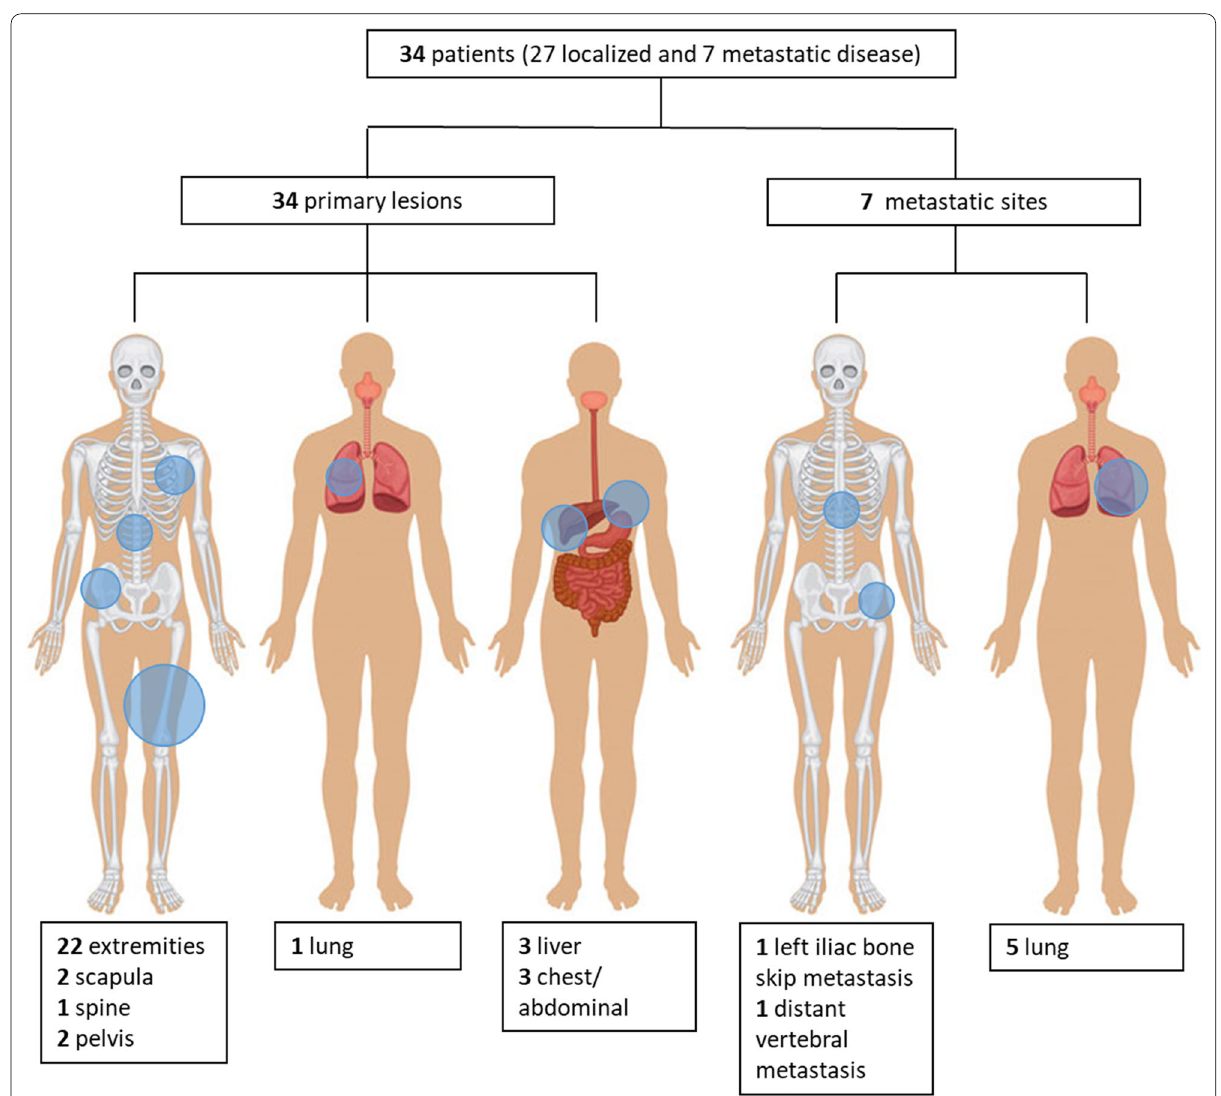
Fig. 3 Overview of primary bone and soft tissue sarcoma localizations and metastatic